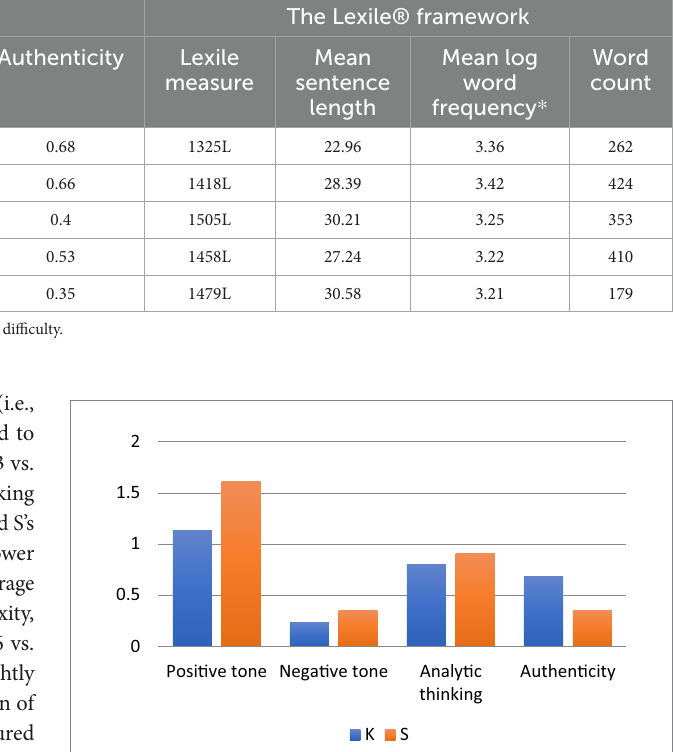
FIGURE 1 LIWC analyses of content: K vs. S.